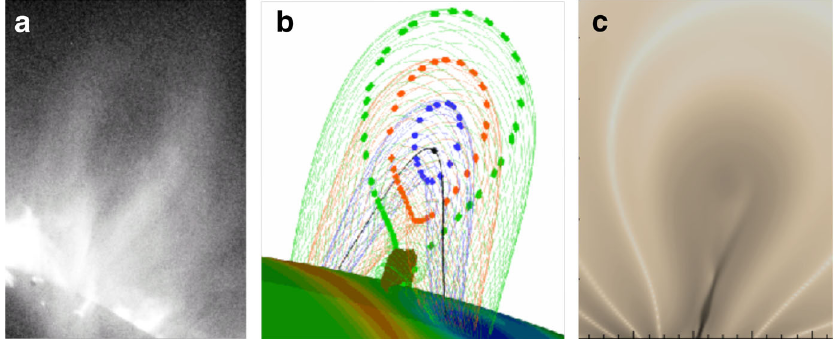
Fig. 15 Cavities with teardrop morphologies are likely to erupt. a Hinode XRT observations of a cavity (01/11/2011 07:24UT) that erupted about 24h later. Image courtesy K. Reeves. b Intersection of rope flux surfaces with plane of sky (colored dots). Image reproduced with permission from Forland et al. (2013), copyrightbytheauthors—thismaybecomparedtoFig.13ewhichrepresentsafluxropewithaBPSS,while the teardrop morphology of this figure represents a flux rope with an underlying X line. c Development of a teardrop morphology manifests as current enhancements (darker grey) within a torus-unstable erupting flux rope. Image reproduced with permission from Aulanier et al. (2010), copyright by